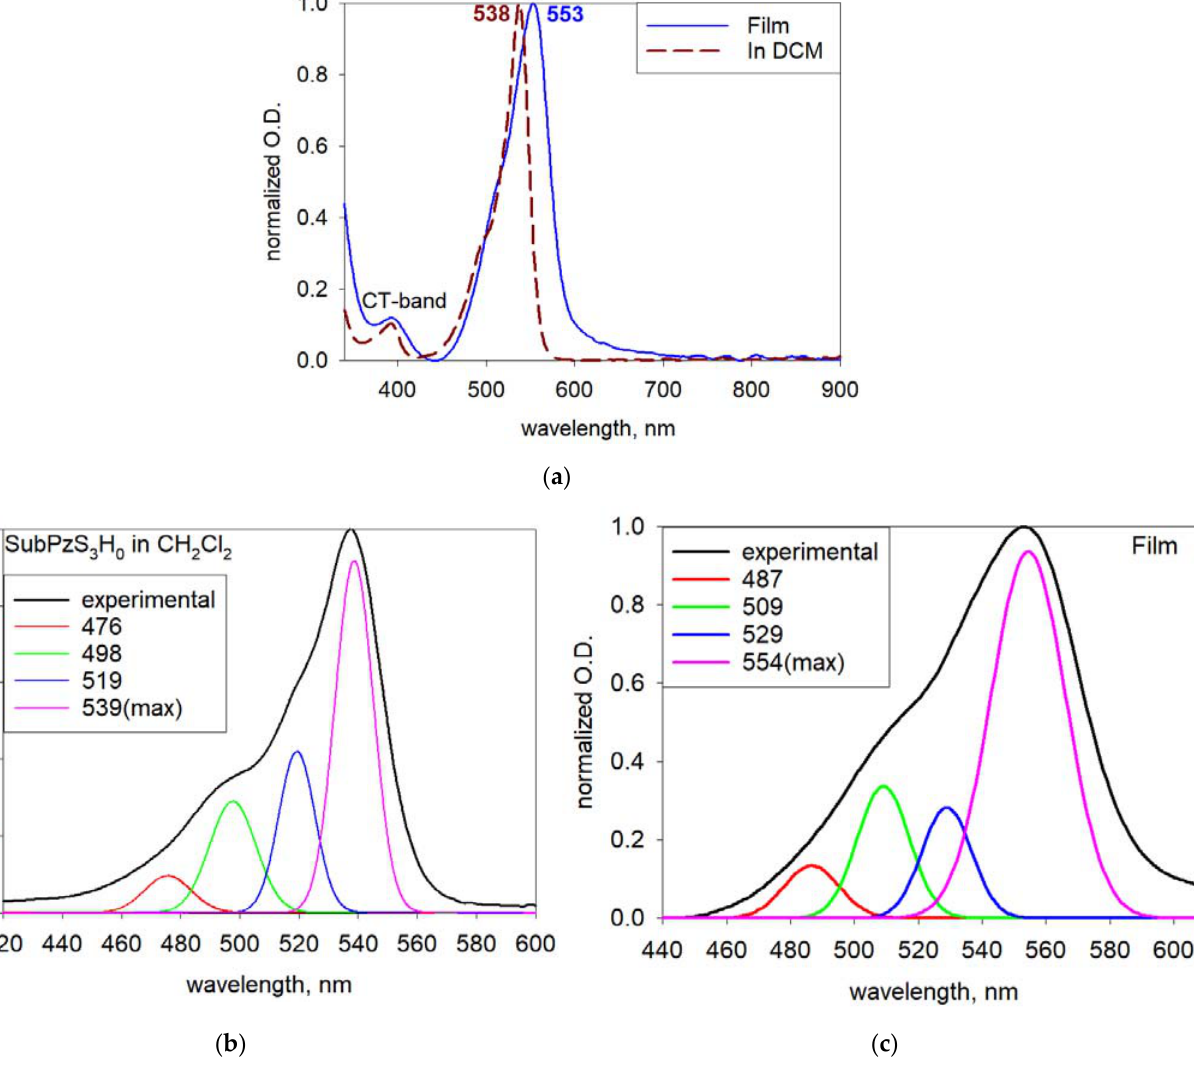
Figure 4. ( a ) Absorption spectra of SubPzS 3 H 0 dissolved in DCM and thin sublimed film on glass; deconvolution results for Q-band in solution ( b ) and film ( c ).